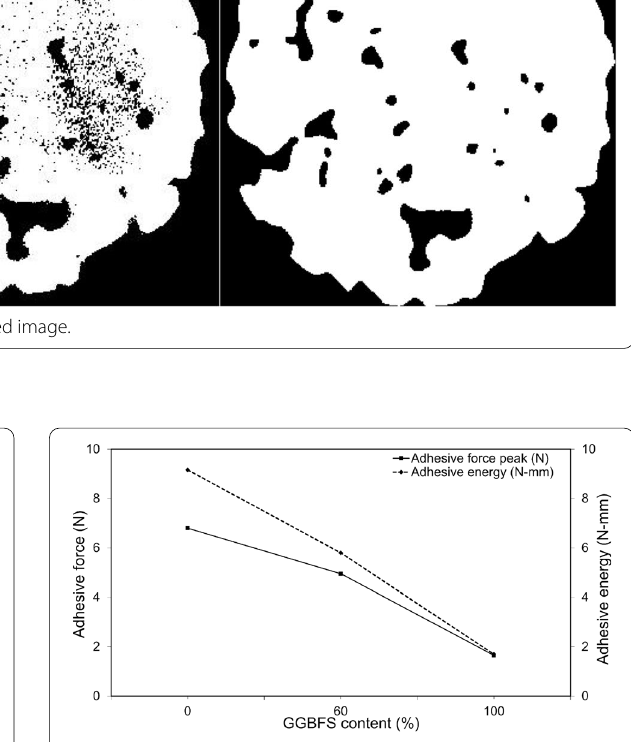
Fig. 11 Adhesive force and energy of the